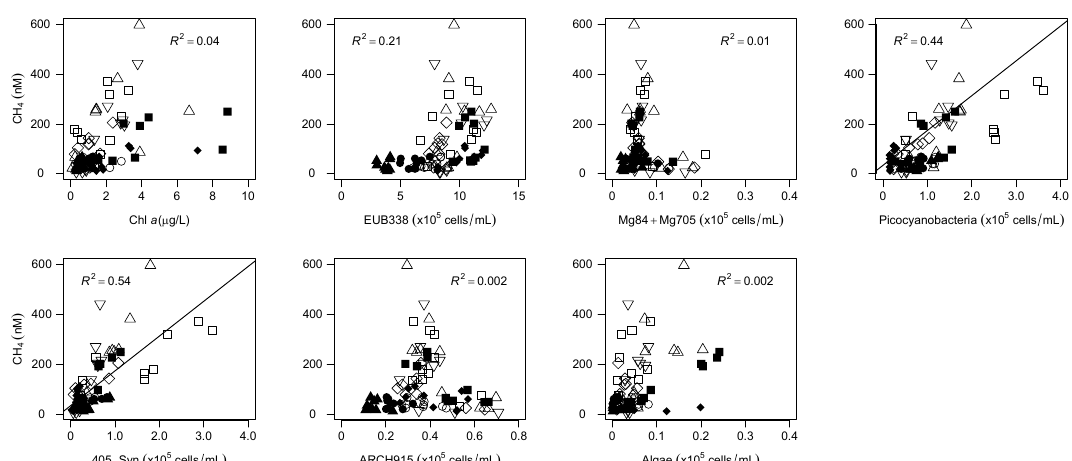
Figure 5. Relationships between the dissolved CH 4 concentration and the cell density of microbial communities in study lakes. EUB338, bacteria; Mg84 + Mg705, type-I methane-oxidizing bacteria; 405_Syn, Synechococcus ; ARCH915, Archaea (see Table S4). GLM with a Gaussian error distribution and an identity link function was used for the variables, while regression lines shown when significant ( p < 0.05). See the legend for Figure 2 for a description of the symbols.